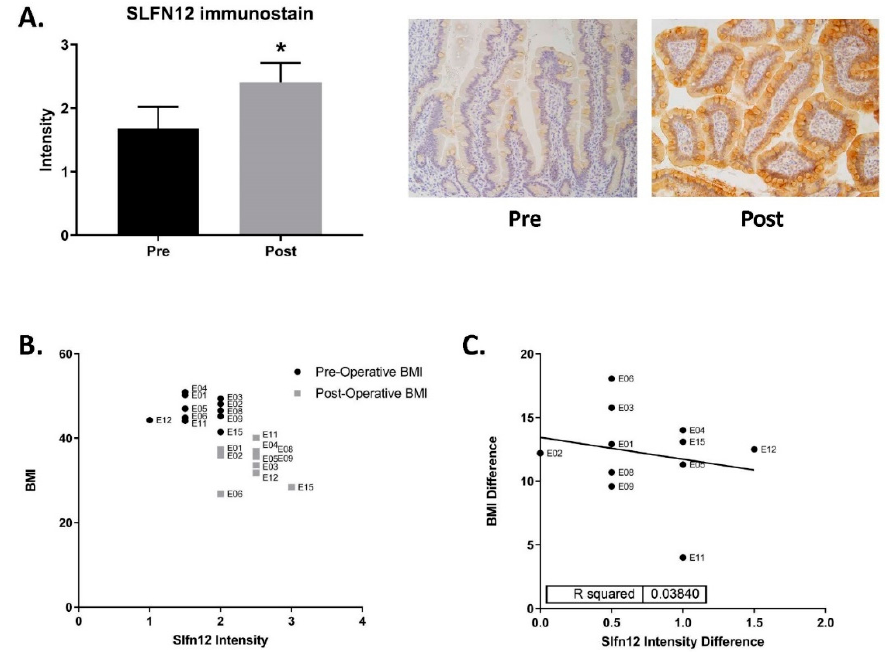
Figure 5. SLFN12 protein expression increases after gastric bypass. ( A ) Immunohistochemical staining in the intestinal mucosa for SLFN12 protein in pre- and post-RYGB samples and scoring by blinded observers. (Two observers each achieved similar results, * p ≤ 0.05.) ( B ) Comparison of patient BMI and SLFN12 protein intensity pre- and post-gastric bypass. ( C ) Correlation graph of the BMI difference vs. the SLFN12 protein intensity difference between pre- and post- gastric bypass samples. ( n = 11).